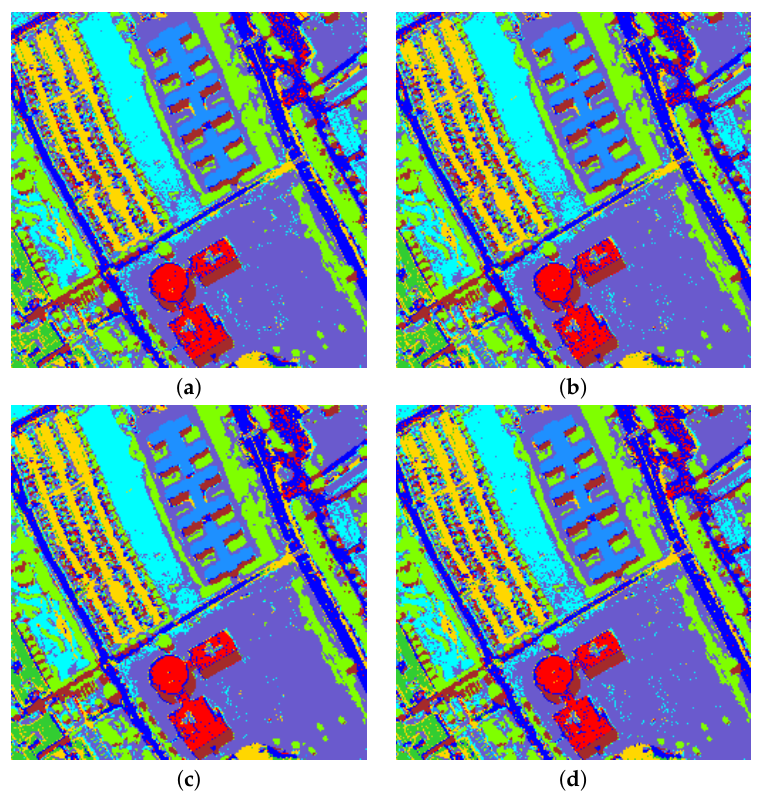
Figure 14. Classification results of the ROSIS HSI after denoising by: ( a ) SDNW-MLR; ( b ) SDNW-MWF; and ( c ) SDNW-MWPT-MWF. The classification result without denoising ( d ) is supplied as a benchmark. ( SNR INPUT = 30 dB). Table 4. OA (%) and Kappa of the classification of the denoised ROSIS HSI, SNR INPUT = 30 dB. Methods